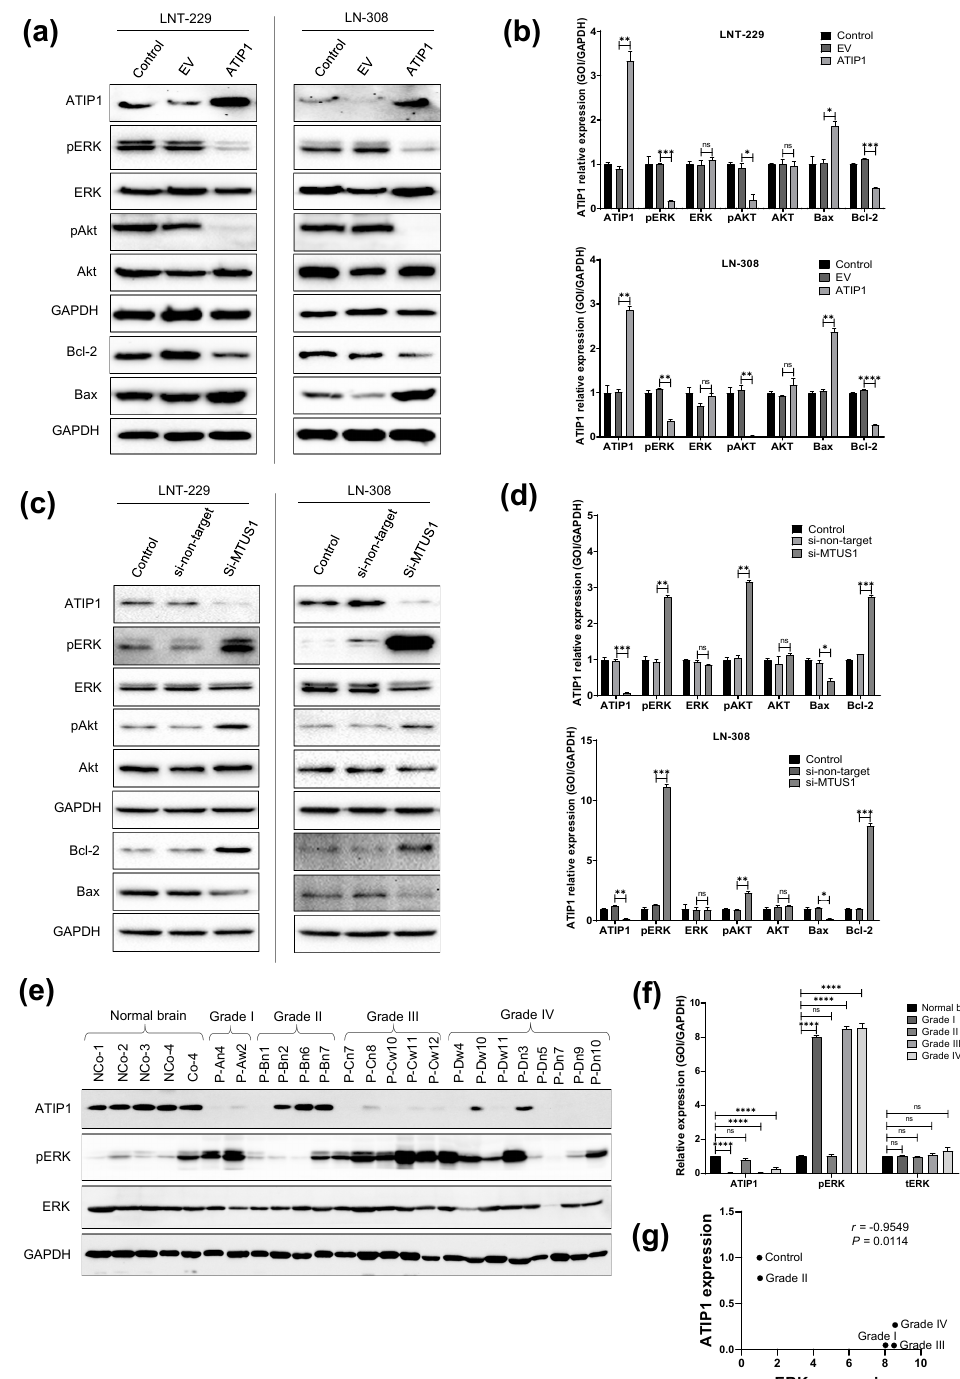
Figure 4. Enhanced expression of ATIP1 modulates the activity of glioma-associated signaling pathways. ( a , c ) Western blot of ATIP1, p-ERK, ERK, p-AKT, AKT, BAX and BCL-2 in parental (control), pcDNA3.1 (EV) and pcDNA3.1-ATIP1 (ATIP1) stably transfected LNT-229 and LN-308 cells ( a ) or 72 h after transient si-RNA transfection of parental LNT-229 and LN-308 cells. ( c ) GAPDH served as the loading control. One representative experiment out of three is shown. ( b , d ) Quantification of the above-mentioned proteins (n = 3, SEM; ns, * p < 0.05, ** p < 0.01, *** p < 0.001, **** p < 0.0001). ( e ) Western blot of ATIP1, p-ERK and ERK in glioma specimen (n = 3). ( f ) Quantification of the above-mentioned proteins in glioma specimen of different WHO grades (n = 3, ns, * p < 0.05, ** p < 0.01, *** p < 0.001, **** p < 0.0001). ( g ) Pearson parametric correlation test was used to analyze the significance between ATIP1 and p-ERK expression in glioma samples of different WHO